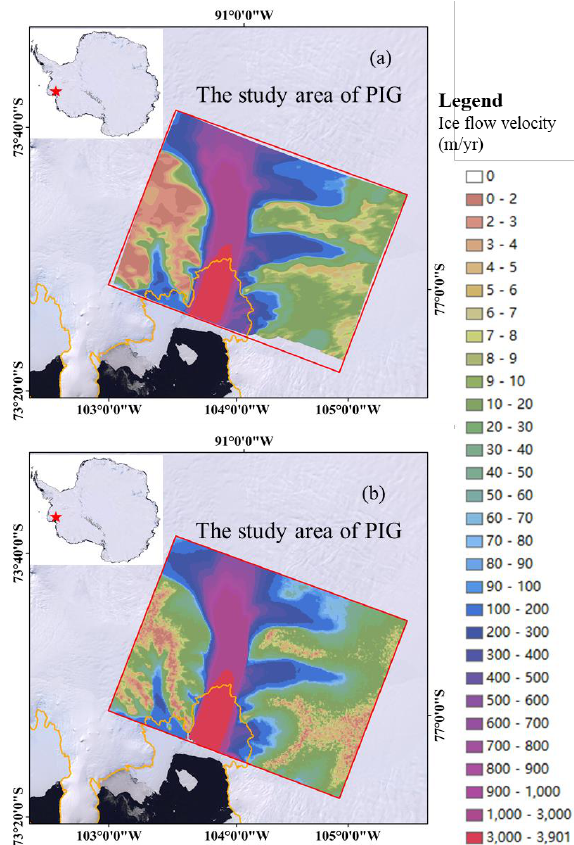
Figure 4 . Scatter diagram of our product and Rignot’s (Mouginot et al., 2017). The x-axis is the velocity of our product, the y-axis is the velocity of Rignot’s. The slope of the blue line is 1, indicating the position when our velocity is equal to that of Rignot.